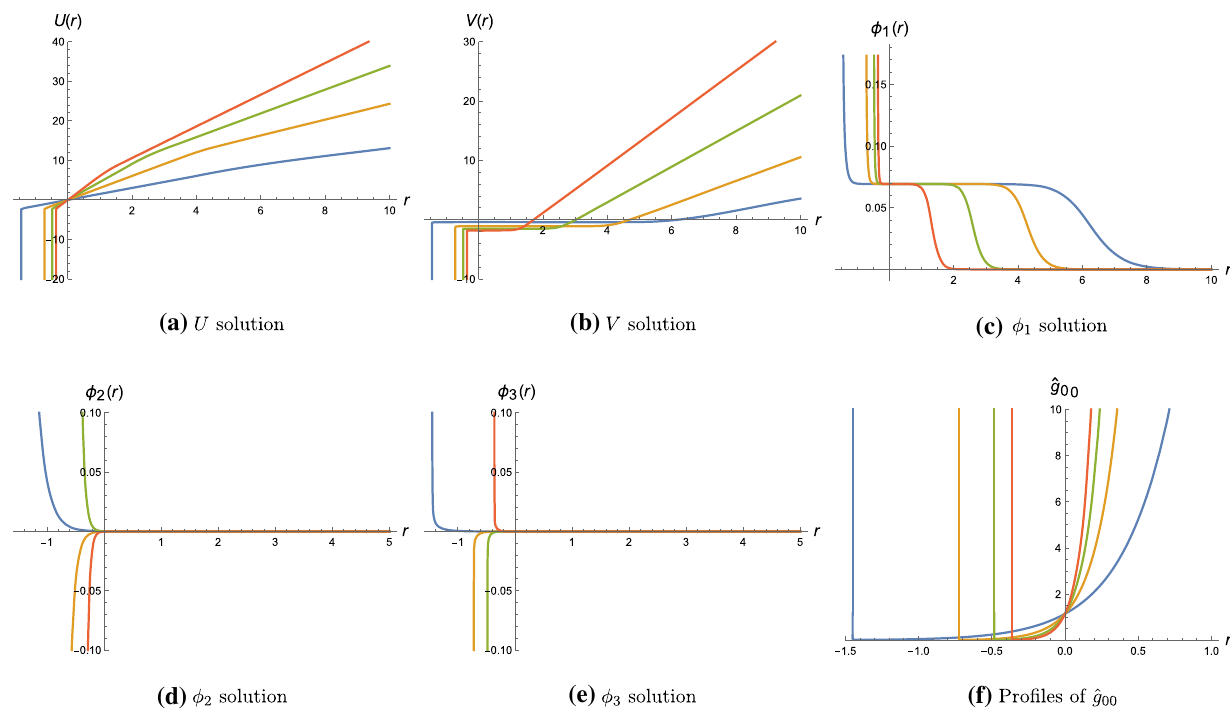
Fig. 10 RG flows from the N = 4 AdS 7 critical point to the AdS 4 × H 3 fixed point and curved domain walls for SO ( 3 ) twists with φ 1 , φ 2 and φ 3 non-vanishing. The blue, orange, green and red curves refer to g